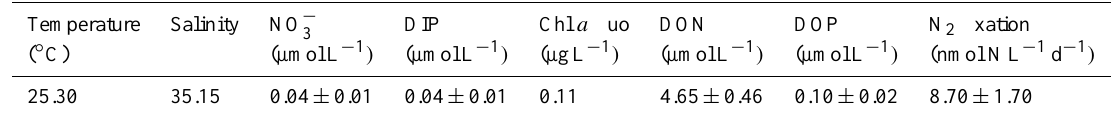
Figure 4. Horizontal and vertical distributions of seawater temperature ( ◦ C), salinity and fluorescence (µgL − 1 ) in M1 (a, e, i) , M2 (b, f, j) , M3 (c, g, k) and lagoon waters (d, h, l) . The grey bars indicate the timing of the DIP spike on day 4. Table 2. Initial conditions (hydrological and biogeochemical parameters) recorded at 6m depth just before the mesocosm deployment (13